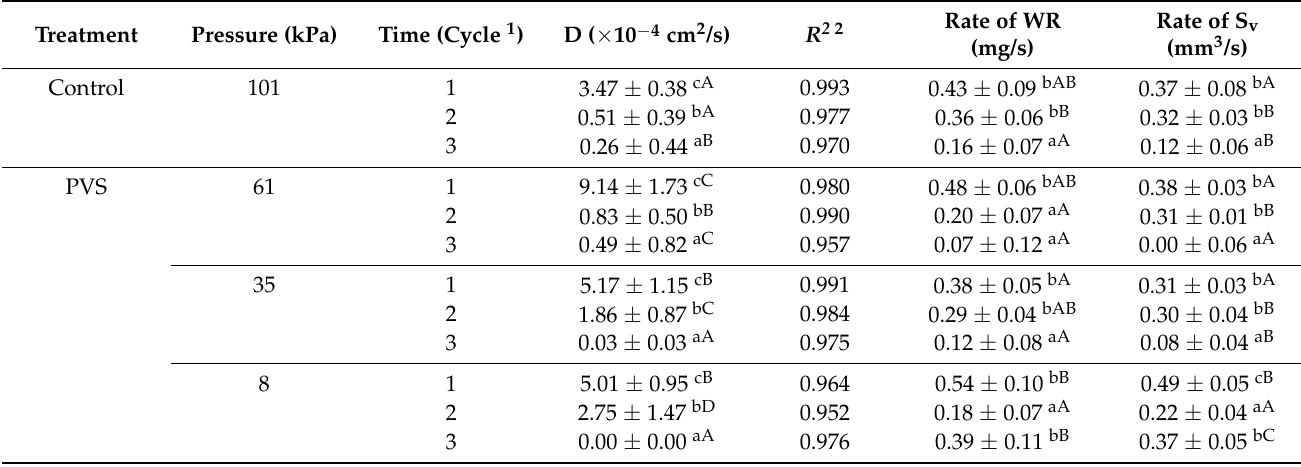
Table 1. Effect of working pressures and time on the diffusion coefficients (D) of calcium ion, rate of weight reduction (WR), and rate of shrinkage (S v ) of calcium-alginate hydrogel